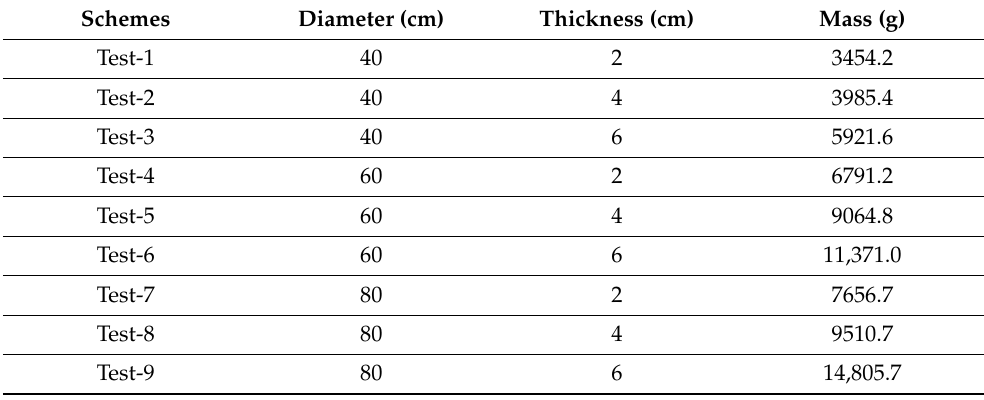
Table 2. Coal pile combustion experimental schemes.